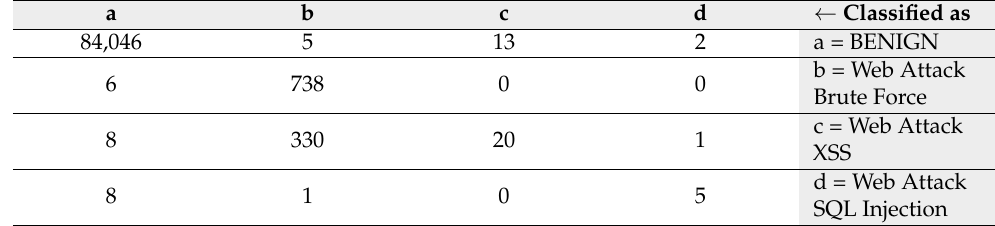
Table 11. Confusion Matrix for J48 on Thursday Morning Web Attacks (multiclass classification).